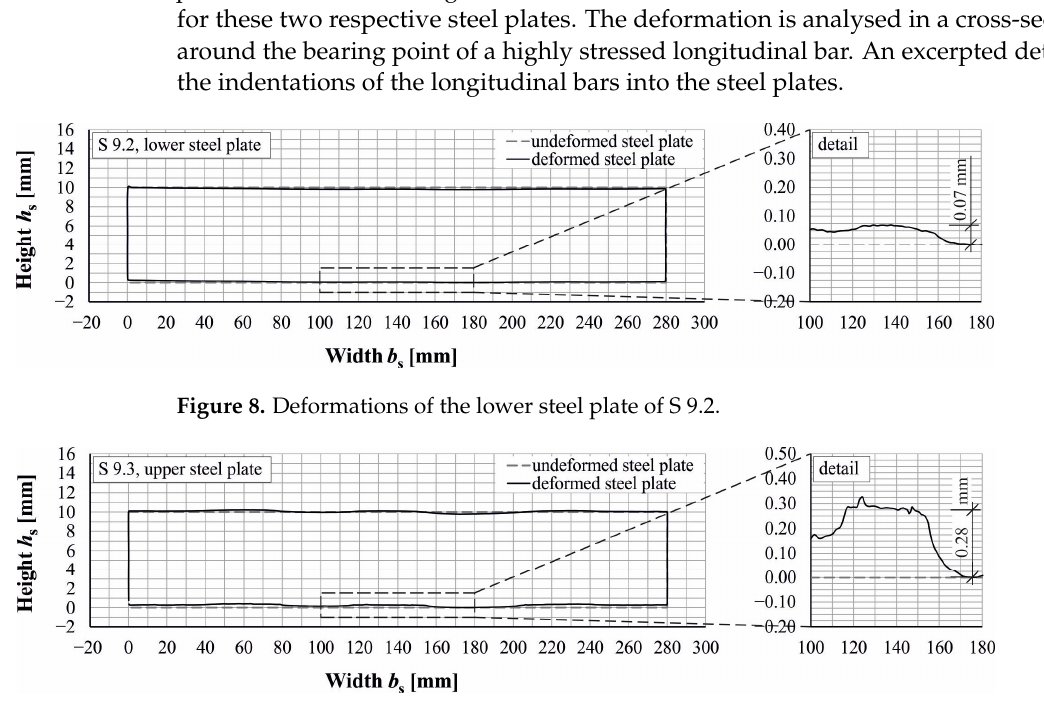
Figure 9. Deformations of the upper steel plate of S 9.3.